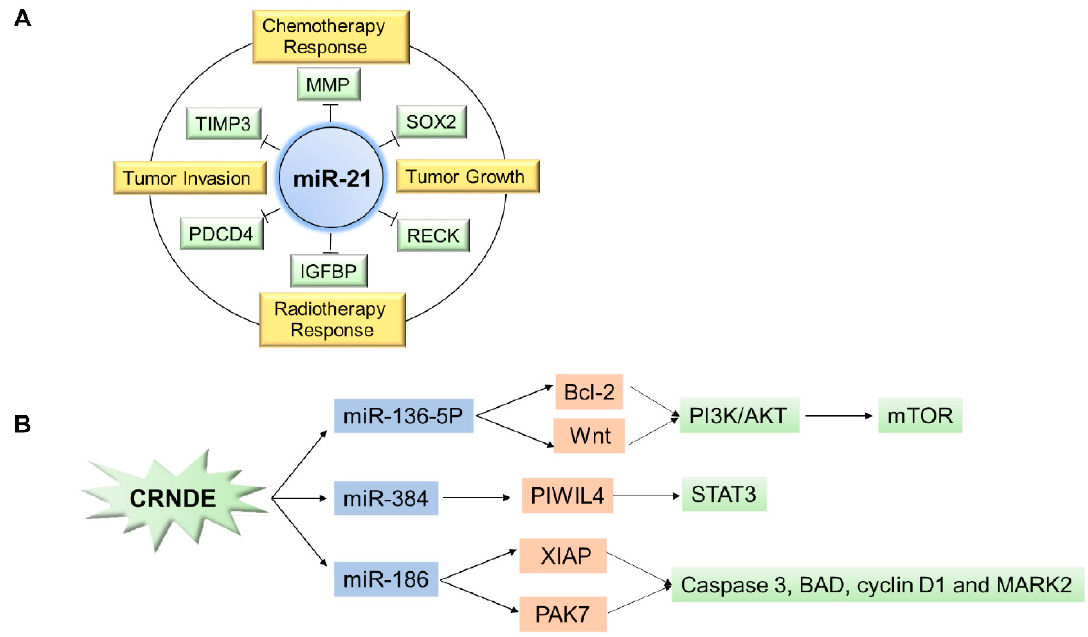
Figure 2. The roles of ncRNAs (miRNA, lncRNA, and circRNA) in regulating glioma biological behavior. ( A) Functional role of miR-21 in glioma; ( B ) Functional role of lncRNA CRNDE in glioma.